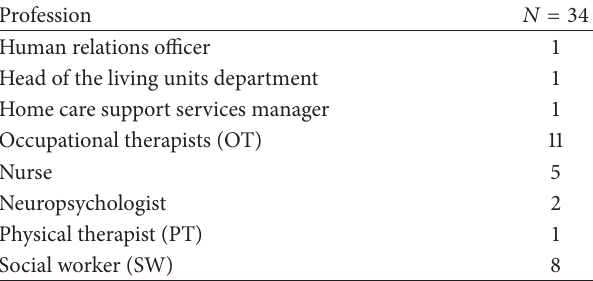
Table 1: Sample size according to